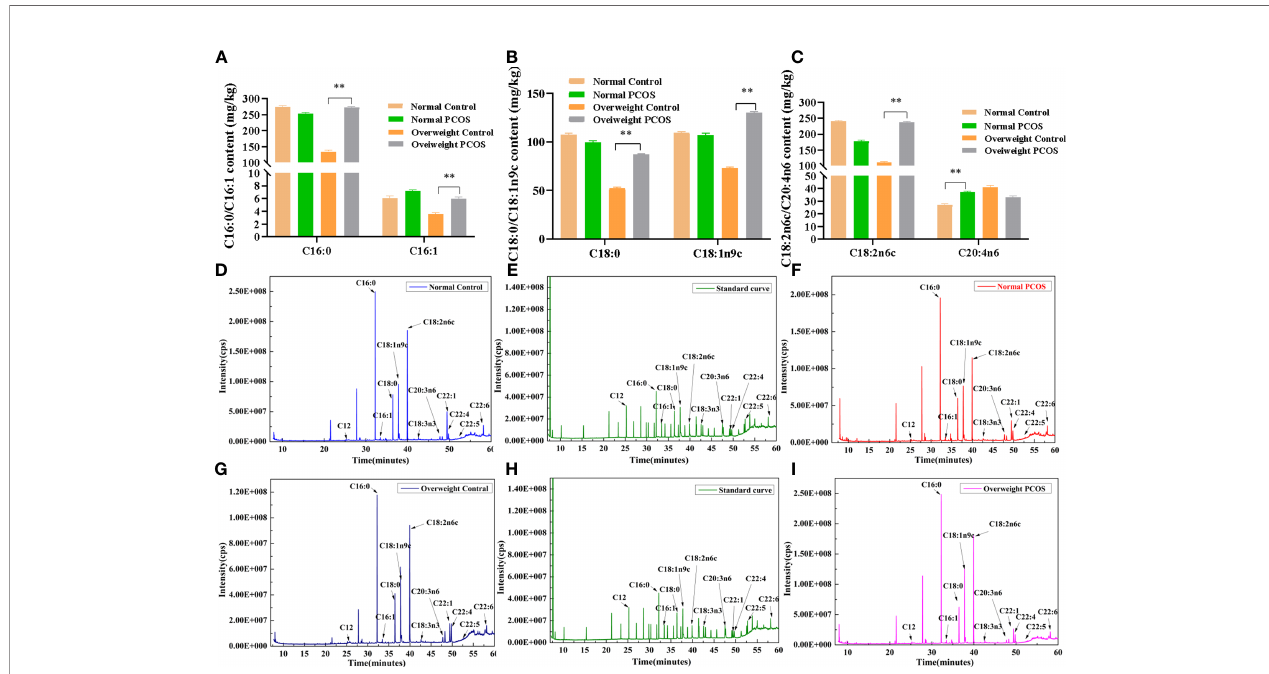
FIGURE 1 | Fatty acid composition in follicular fl uid. (A – C) C16:0 、 C16:1 、 C18:0 、 C18:1n9c 、 C18:2n6c 、 C20:4n6 between the overweight PCOS patients 、 the overweight control subjects 、 the normal PCOS patients and the normal control subjects. (D – I) Representative GC-MS chromatograms of follicular fl uid (FF) speciens from patients that underwent IVF. (D) FF from a normal control (B) FF from a normal PCOS (E, H) Chromatograms of 35 standard fatty acid in a standard mixture (G) . FF from a overweight control (I) . FF from an overweight PCOS. Different lowercase letters at the top of each bar denote signi fi cant differences among groups. Data represent mean ± standard error, **P < 0.01.